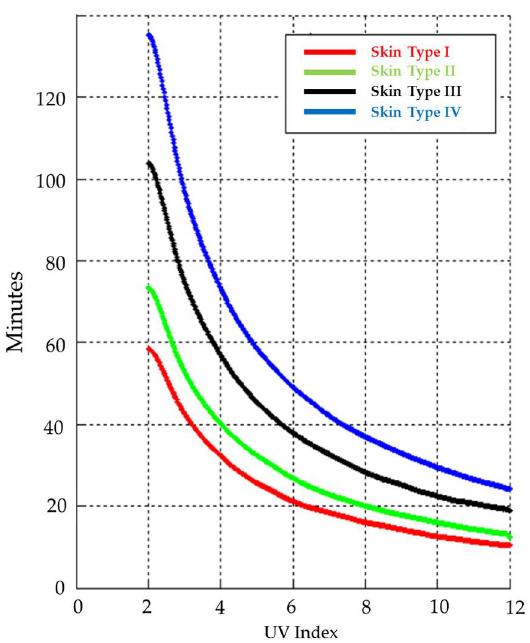
Figure 4. The sunburn times in minutes for skin types I, II, III, and IV and 1 minimal erythemal dose (MED) [10].